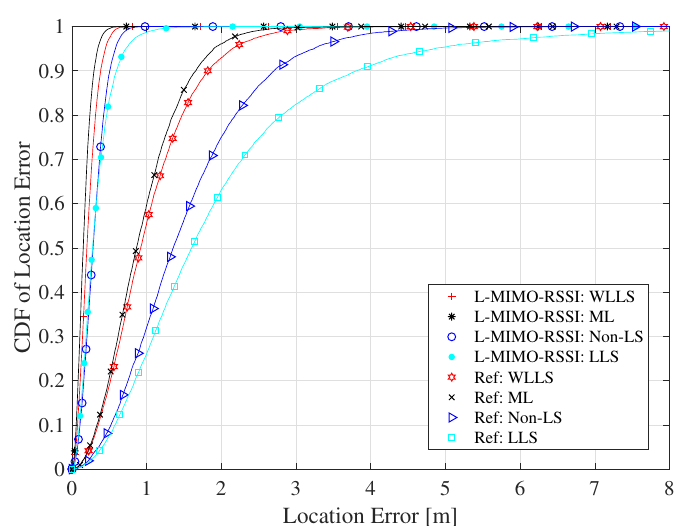
Figure 13. The CDF of localization RMSE for different position estimation algorithms for the LOS environment and the co-polarized antenna configuration.